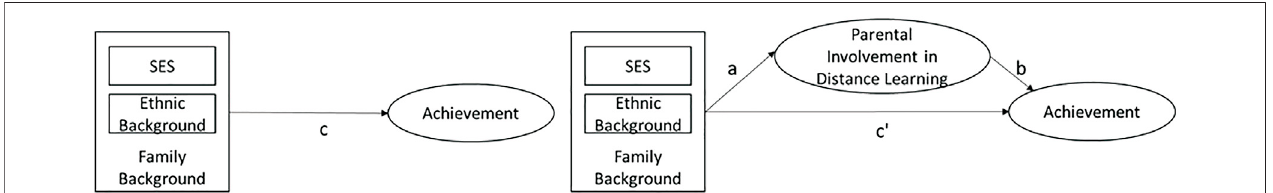
FIGURE 1 | Conceptual mediation